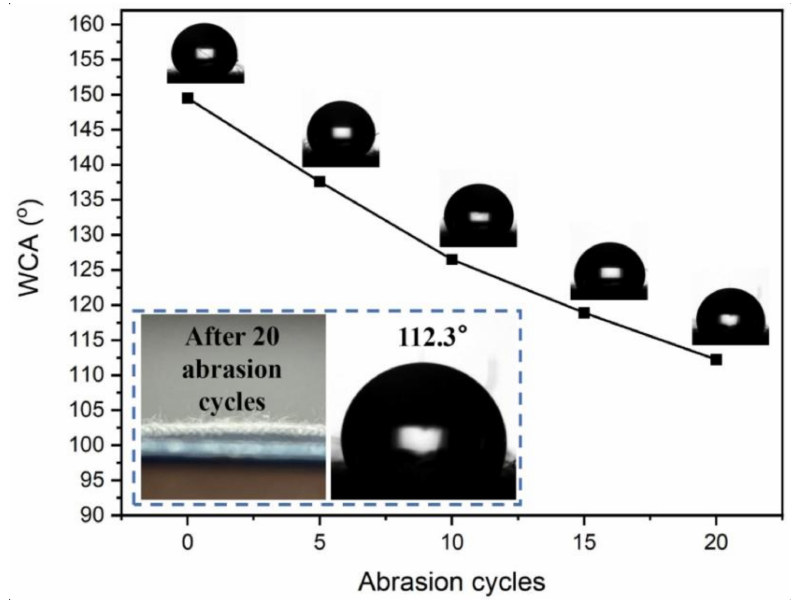
Figure 7. The effect of abrasion cycles on WCA of finished fabric.